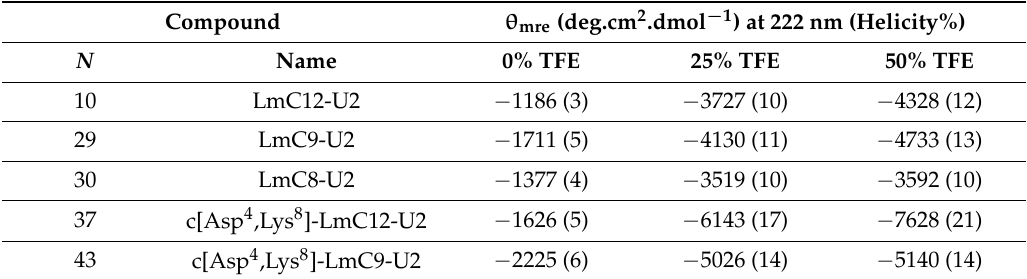
Table 2. α -Helix content estimation on the basis of θ values at = 222 nm a.